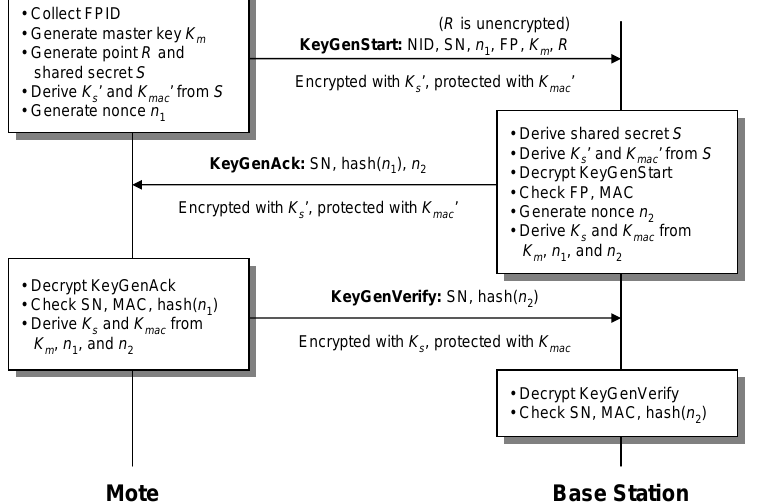
Figure 6. ECC-based key agreement